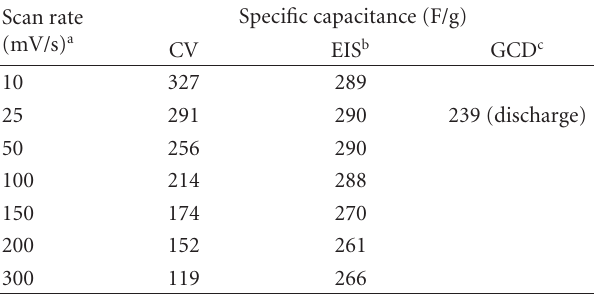
Table 1: Specific capacitance (F/g) of MnO 2 thin-film electrochem- ical capacitor prototypes calculated from cyclic voltammograms (CVs) at di ff erent scan rates, and electrochemical impedance spectroscopy (EIS) at the frequency of 10 mHz.